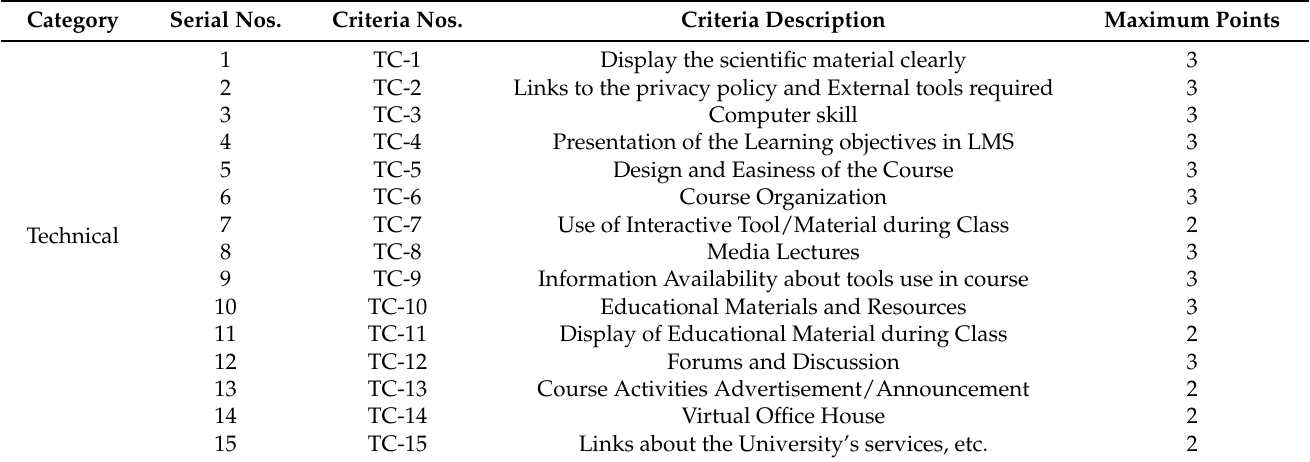
Table 3. QTEF—technical criteria.